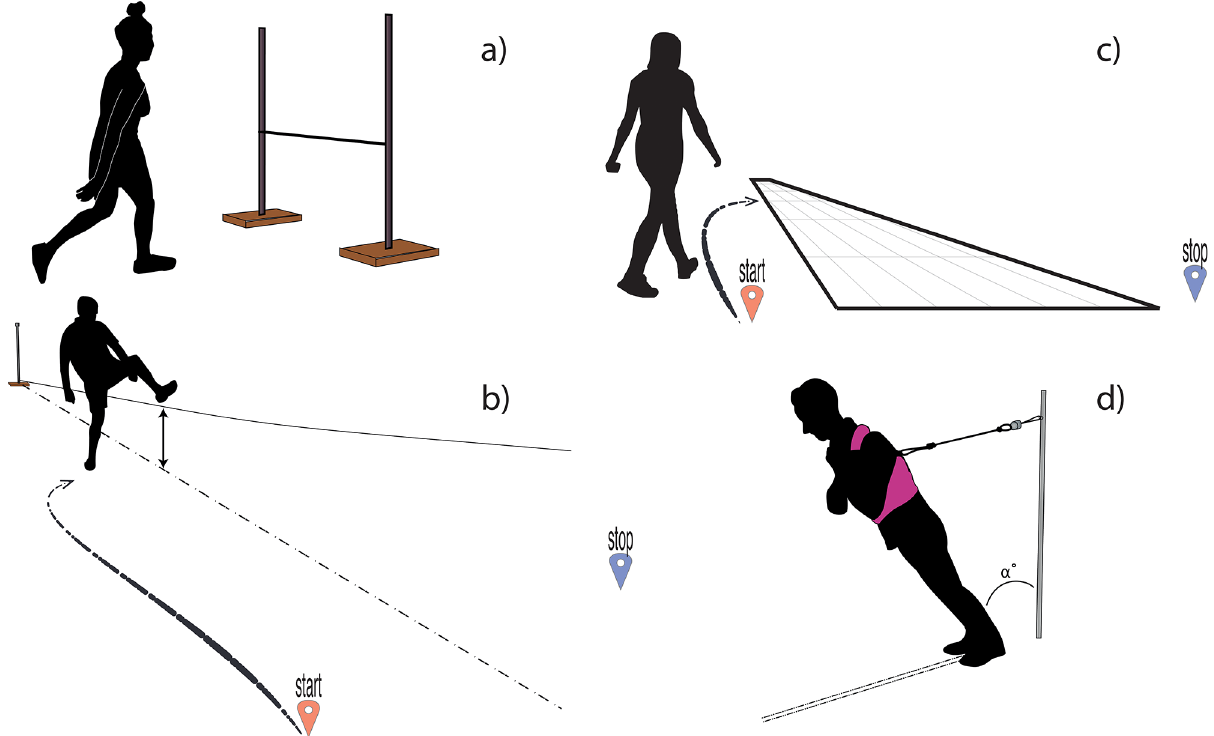
Fig 1. Visualisation of the four motor tasks. (a) Stepping over a raised bar (‘bar’). (b) Crossinga declining cord by steppingover it at a self-selectedheight (‘cord’). (c) Crossinga virtual river by steppingover a peaceof paper at a self-selectedwidth (‘river’). (d) Recovery from a forward fall after an unexpected release from an inclinedposition (‘recovery’). Leaningangle is depictedby the α .